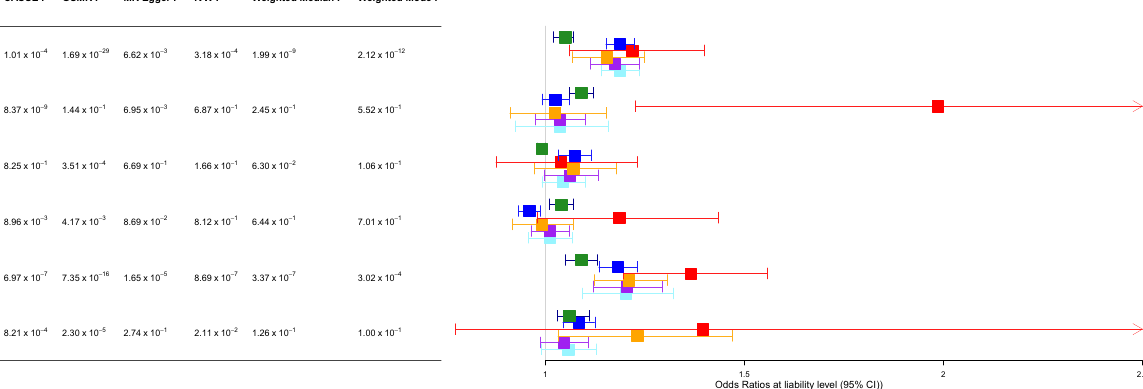
Fig. 3 Summary of bi-directional Mendelian Randomisation (MR) analyses between multiple sclerosis (MS) and each of in fl ammatory bowel disease (IBD), ulcerative colitis (UC) and Crohn ’ s disease (CD). Green: Causal Analysis Using Summary Effect estimates (CAUSE); dark blue: Generalised Summary-data-based Mendelian Randomisation (GSMR); red: MR-Egger; orange: inverse variance weighting (IVW); purple: weighted median; light blue: weighted mode. Error bars represent the 95% con fi dence intervals (CIs) for the associated MR point estimates. See Tables S4, S6 for complete details of the MR analyses. Source data are provided with this paper.